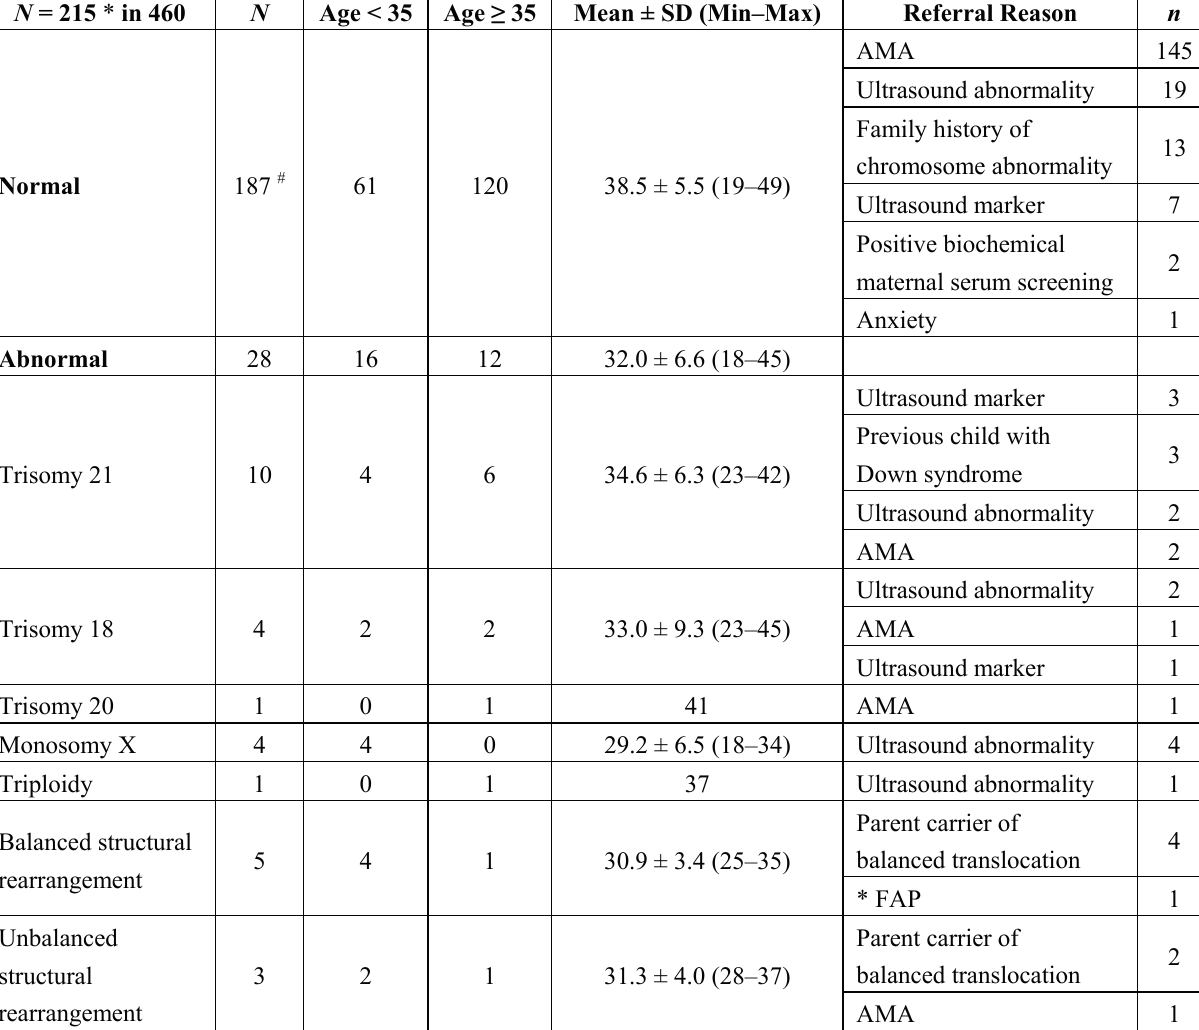
Table 2. Karyotyping results stratified by age and referral reason. N = 215 * in